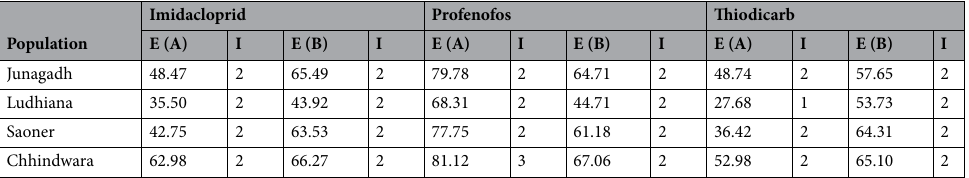
Table 4. Descriptive analysis of reduction in parasitism and emergence rates of Aenasius arizonensis females exposed to lethal doses of the insecticides. Descriptive analysis (E) = Reduction in parasitism (A) or emergence (B) in percent and their respective IOBC toxicity classes (I). Parasitization and emergence rates were estimated for the females of A.arizonensis (of respective field populations) exposed to lethal doses (LC 50 ) of imidacloprid, profenofos and thiodicarb. E(A) = Per cent reduction in parasitization (%); E(B) denotes percent reduction in emergence (%) I refers to IOBC Toxicity classes: 1 = harmless, 2 = slightly harmful, 3 = moderately harmful, 4 = harmful.